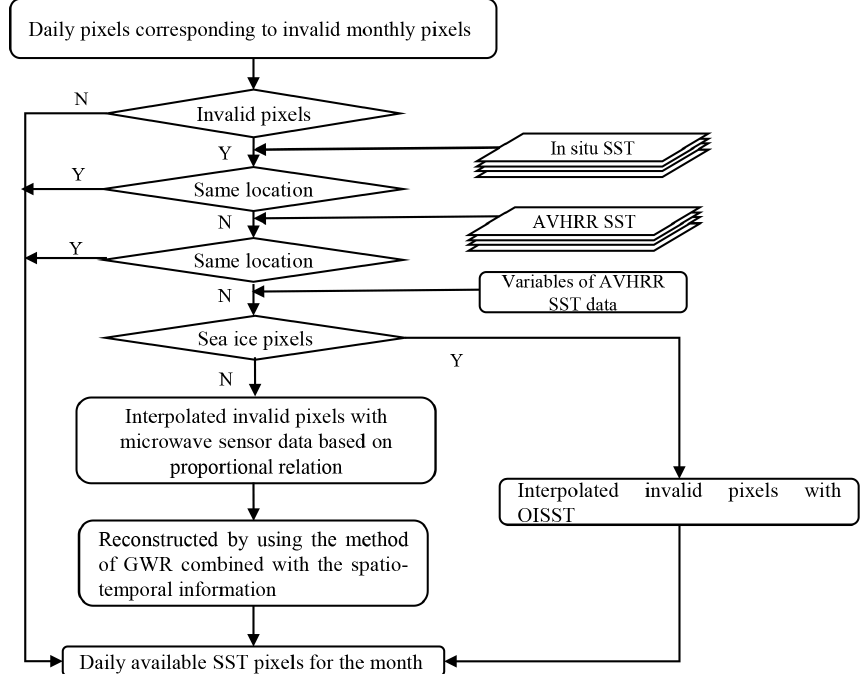
Figure 11. The summary flow chart for reconstructing invalid SST pixels in high-latitude regions of the